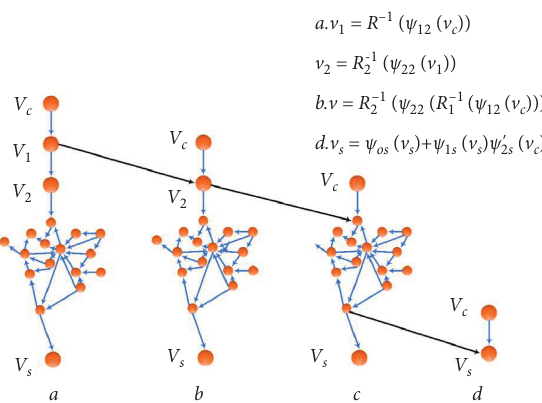
Figure 5: Compressed data node